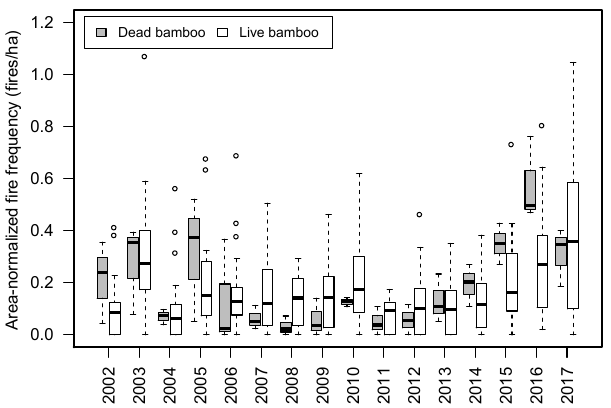
Figure 11. Area-normalized MODIS fire frequency during 2002– 2017. Gray boxes represent fire in dead bamboo (28, 0 and 1 years) and white boxes represent fire in live bamboo (2 to 27